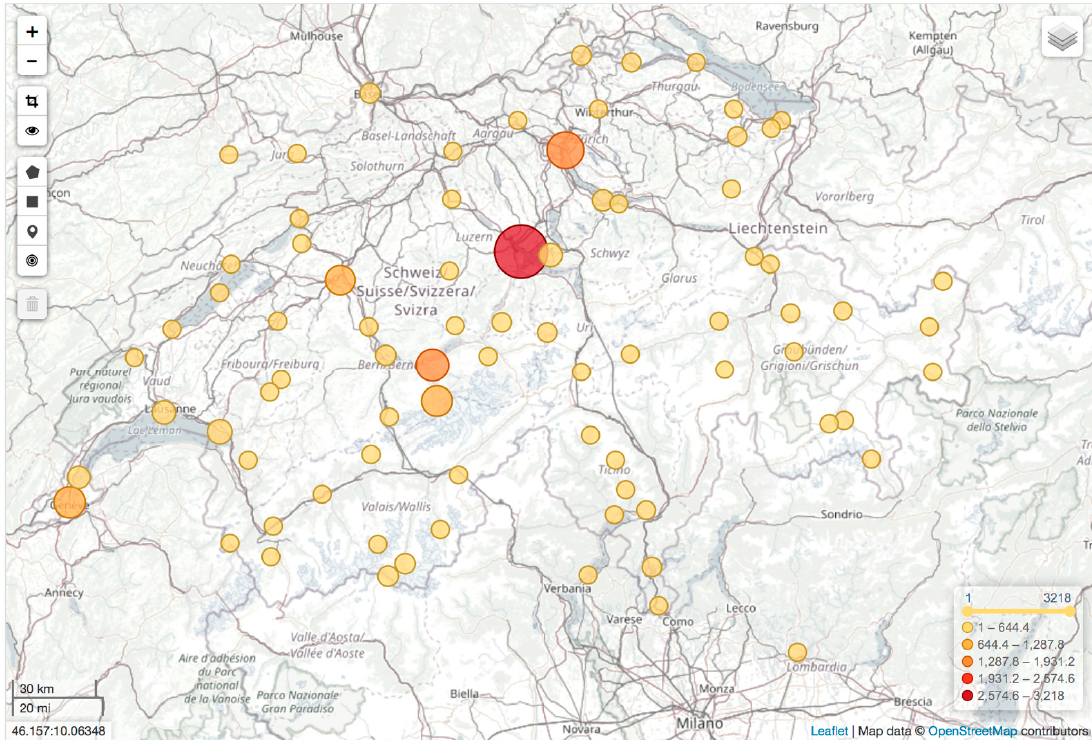
Figure 4. Screenshot: Frequency of comments by users per point of interest visualized on an interactive map of Switzerland. The colour and size of the markers indicate the number of comments collected per POI (data: 26 February, 2012 to 2 November, 2017).